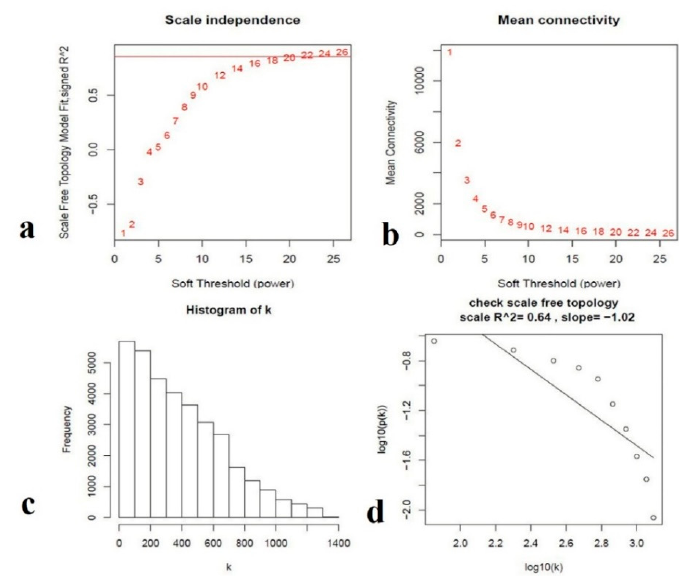
Figure 7. Determination of soft-thresholding power in the gene weighted co-expression network analysis. ( a ) Analysis of the scale-free fit index for various soft-thresholding powers ( β ). ( b ) Analysis of the mean connectivity for various soft-thresholding powers. ( c ) Histogram of connectivity distribution when β = 8. ( d ) Checking the scale-free topology when β = 8.